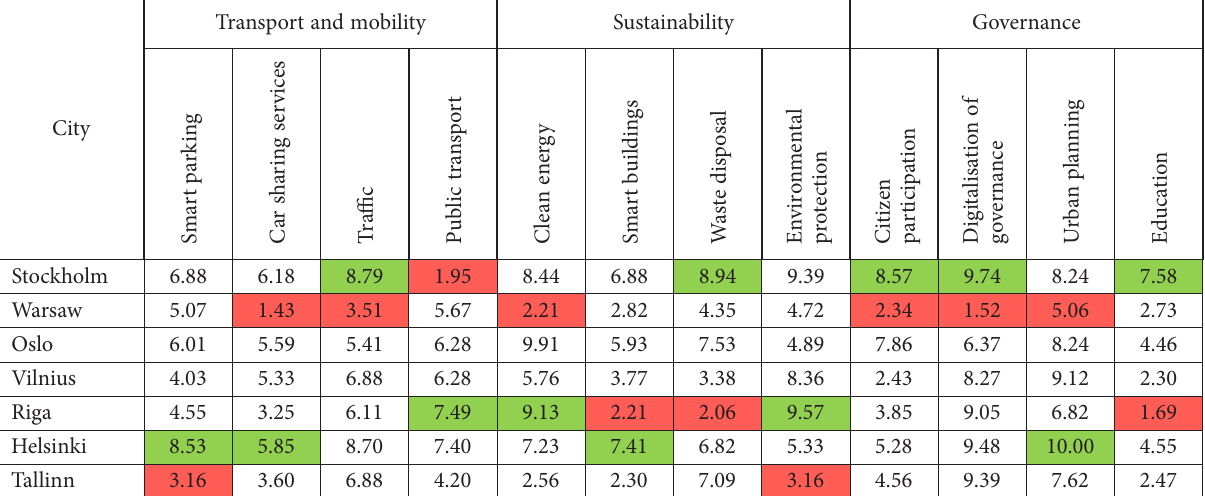
Table 3. Research on 7 Baltic region cities Smart city characteristics Transport and